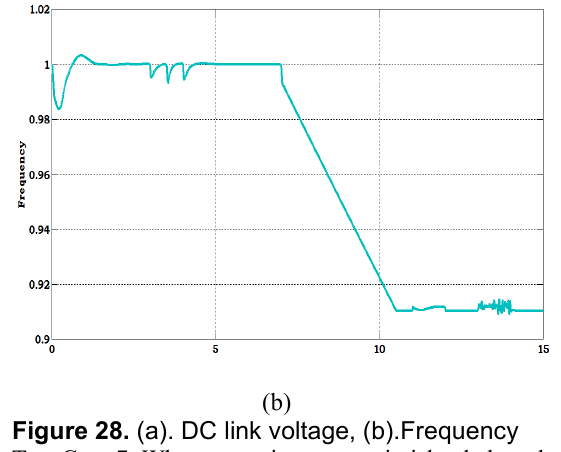
Figure 28. (a). DC link voltage, (b).Frequency